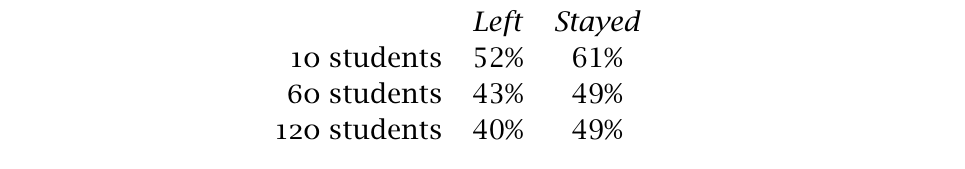
Mean answers by question and cardinality for questions (iii) and